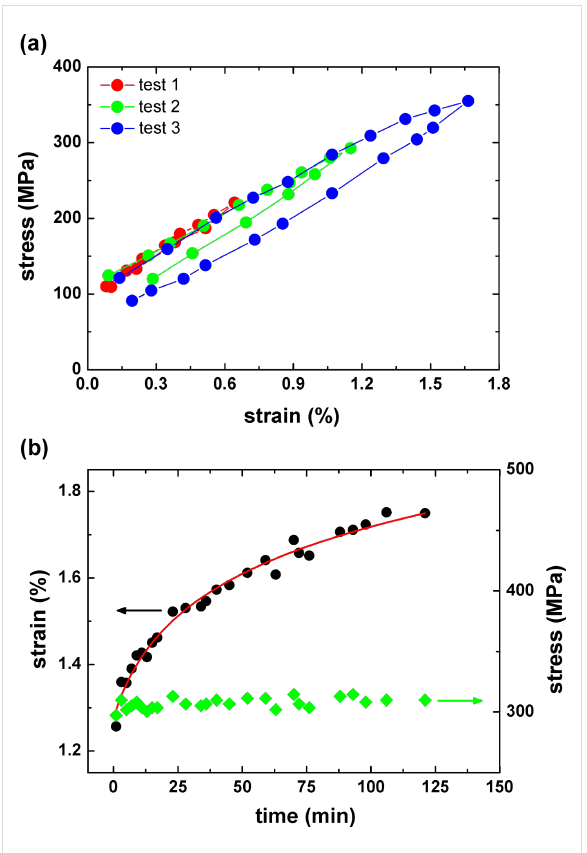
Figure 4: (a) Stress–strain relationship of three loading–unloading measurements on a NBPT CNM with different maximum strains at ~0.65%, ~1.2% and ~1.7%; (b) Strain exhibits a nonlinear increase at a stress of 304 ± 15 MPa, indicating a tensile-creep